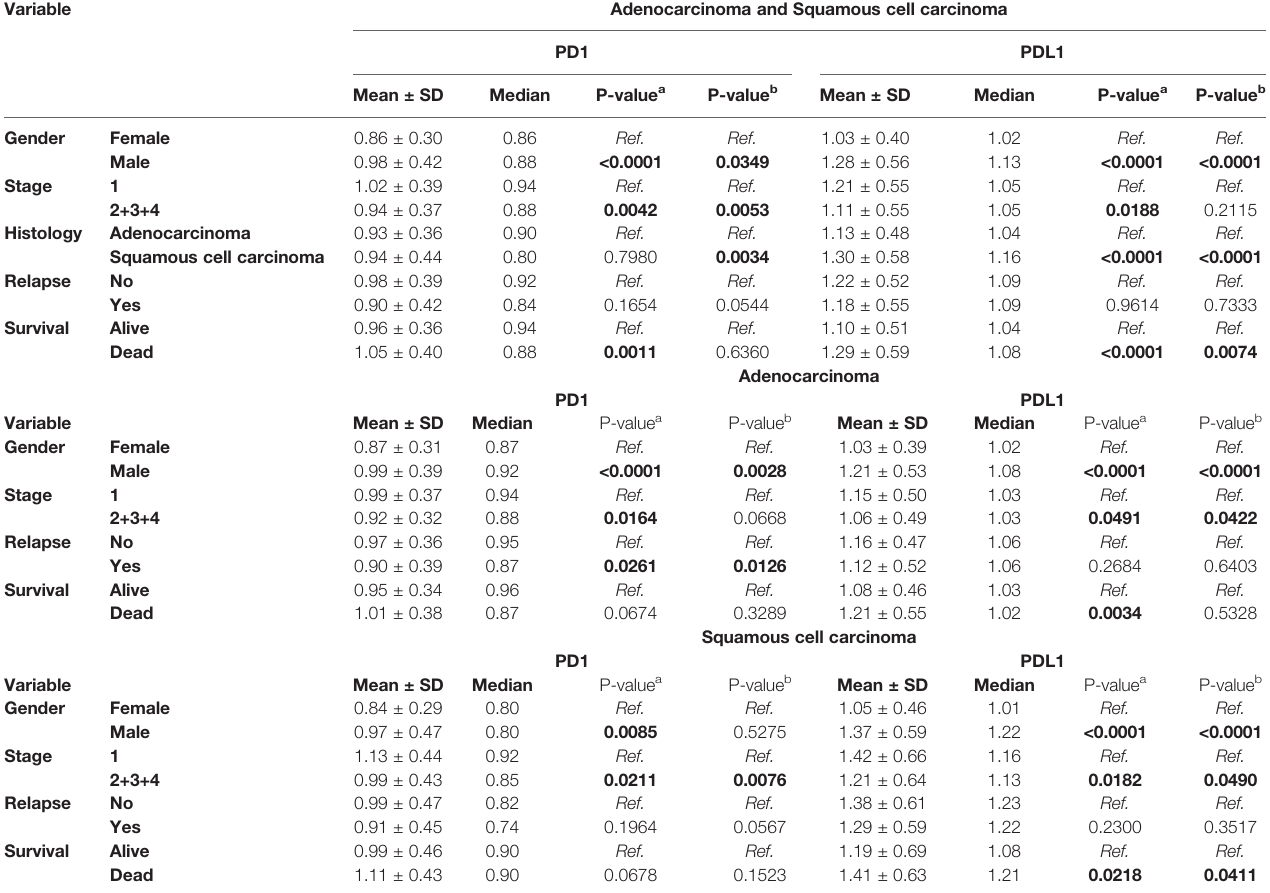
TABLE 1 | Correlation of PD1 and PDL1 gene expression with clinical parameters of lung cancer patients.